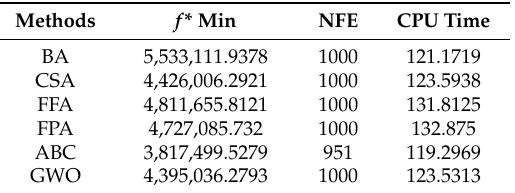
Table 7. Summary of comparison result for support structure cost for FOWTs